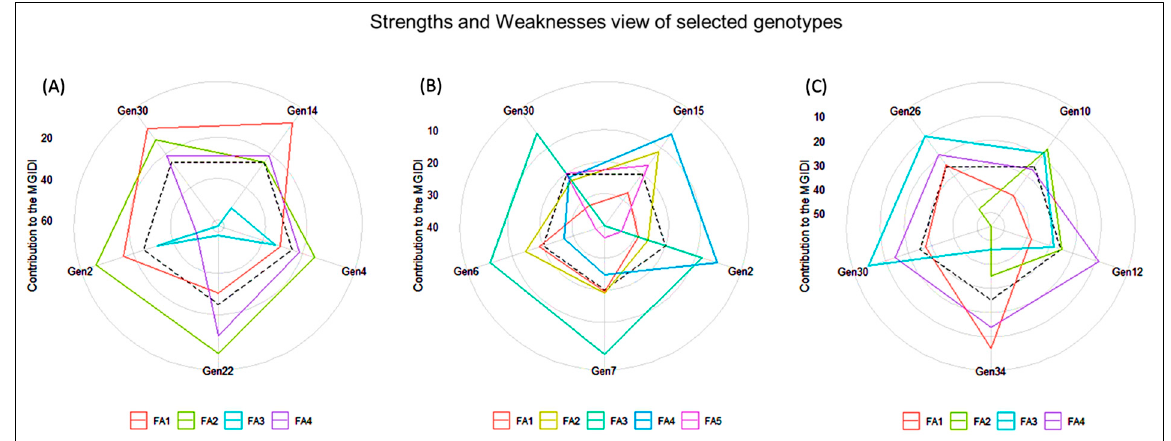
Figure 9. The strengths and weaknesses view of the selected genotypes represent the proportion of each factor on the computed MGIDI index. ( A ) Satkhira, ( B ) Kushtia, and ( C ) Barishal. In Kushtia, for factor 1 (FA1: YPP and YTH), Gen30 were strong and Gen6 were a